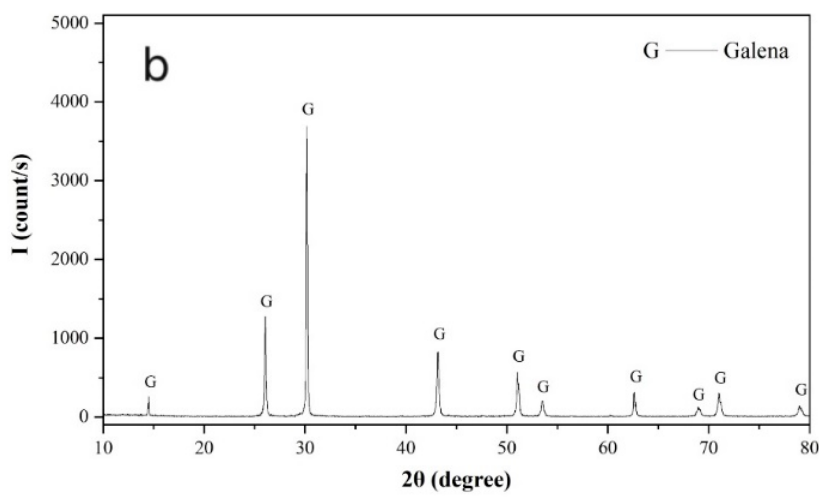
Figure 1. XRD spectrums of ( a ) pyrite and ( b ) galena particle samples.